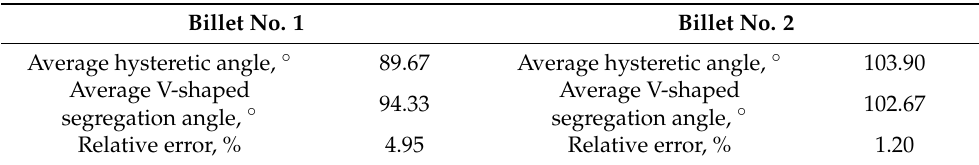
Table 4. Comparison of hysteretic angle and V-shaped segregation angle of billet No. 1 and No. 2.